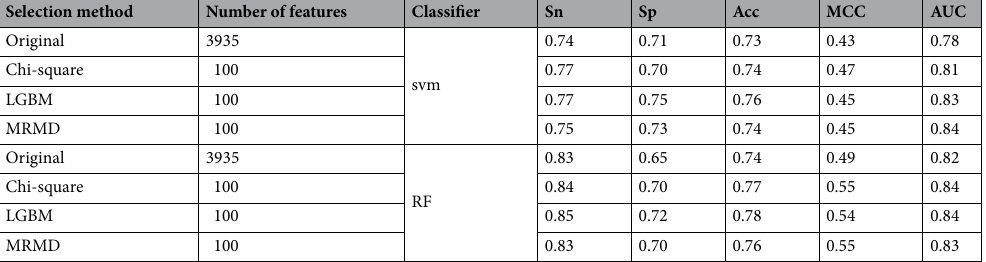
Table 5. Comparison of performance before and after feature selection method in the incorporated feature. Here ‘original’ corresponds to the incorporated feature, which is AAC + AAPC + BE + CKSAAP +EAAC + EGAAC + PSSM, of 3935 dimension. ‘Chi-square’ corresponds to the selected top-100 dimension of features after selection in Chi-square method, ‘LGBM’ corresponds to the selected top-100 dimension of features based on LGBM feature selection method, ‘MRMD’ corresponds to the selected top-100 dimension of features based on MRMD feature selection method.